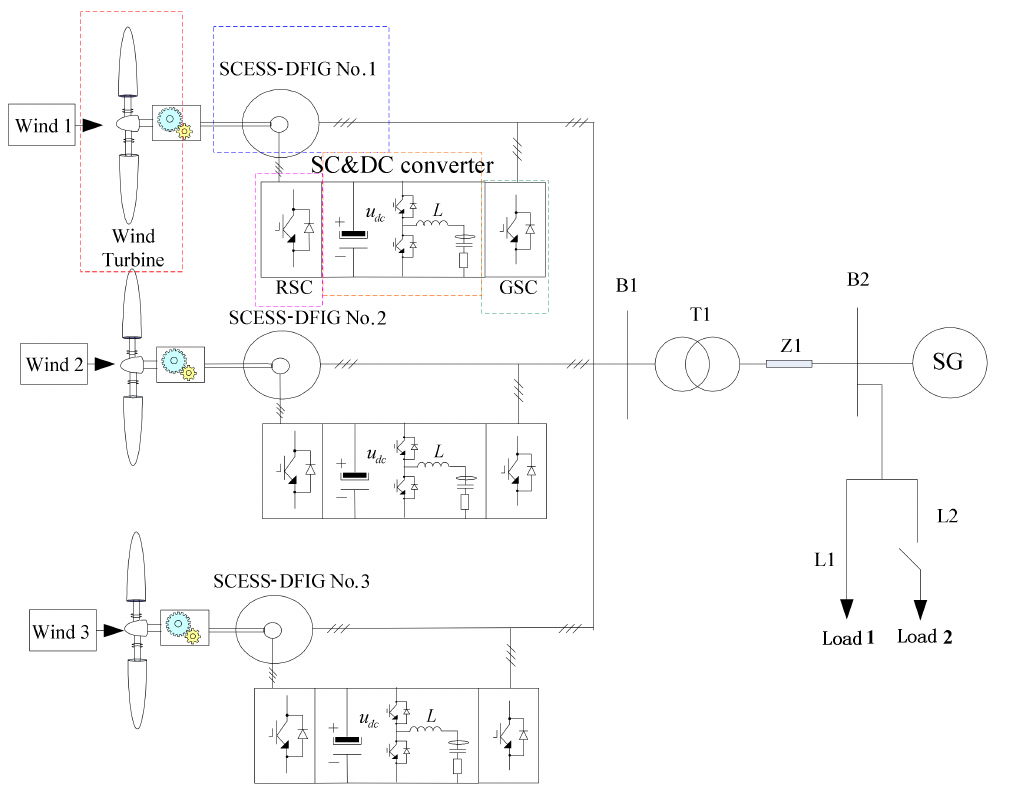
Figure 10. Simulation system diagram. SG: synchronous generator.